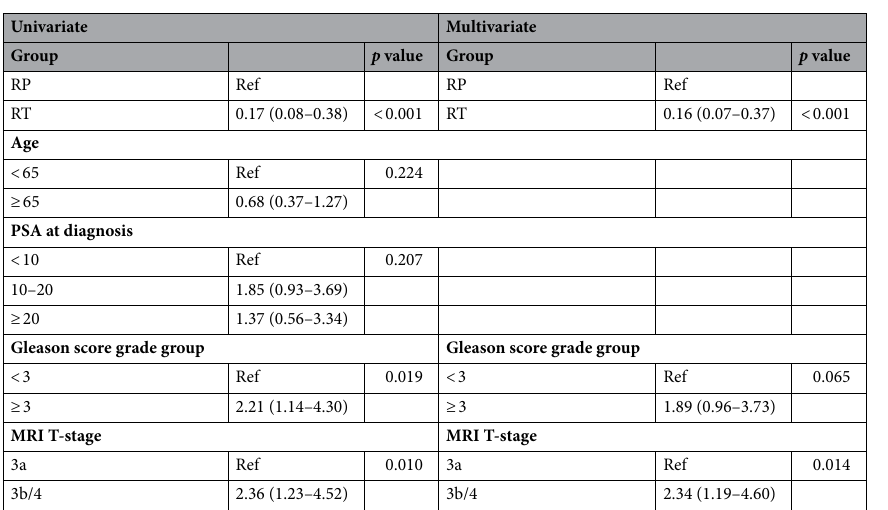
Table 2. Cox regression for biochemical-recurrence free survival in propensity score-matched patients. Cox proportional hazards models with 95% confidence interval were used to analyze the relationships between clinical variables and biochemical recurrence. We calculated multivariate cox regression analysis when clinical variables with p < 0.2 at univariate cox regression analysis. Two-sided p values were calculated and a level of < 0.05 was considered statistically significant. RP radical prostatectomy, RT